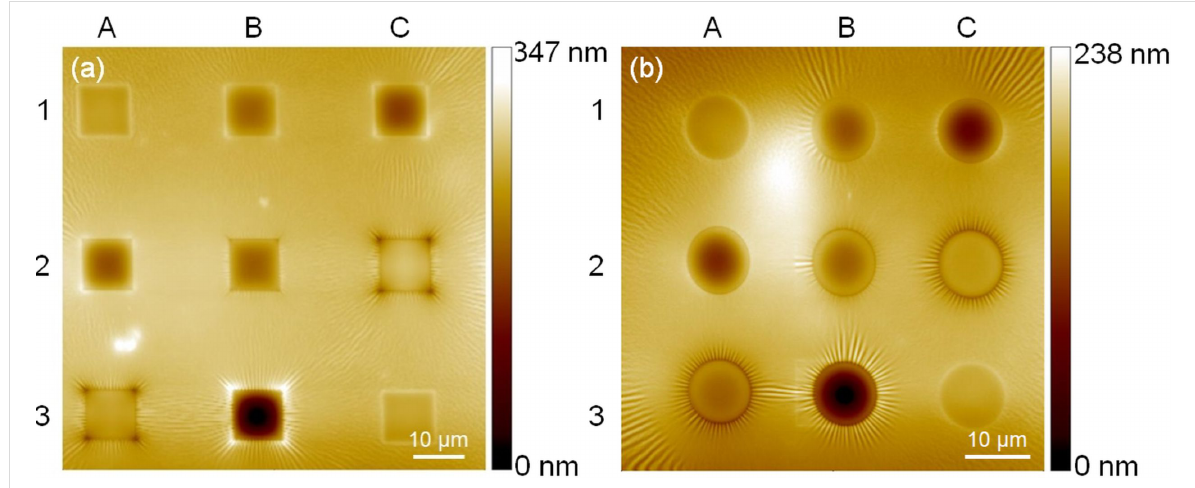
Figure 7: HIM images of square (a) and circular (b) arrays produced in 15 nm Pt 60 Pd 40 /PDMS samples by irradiation with different fluence values of 25 keV-He + ions. In both images, the irradiation fluence increases in the following raster scan order: A1 (3.7 × 10 13 cm − 2 ), B1 (2.0 × 10 14 cm − 2 ), C1